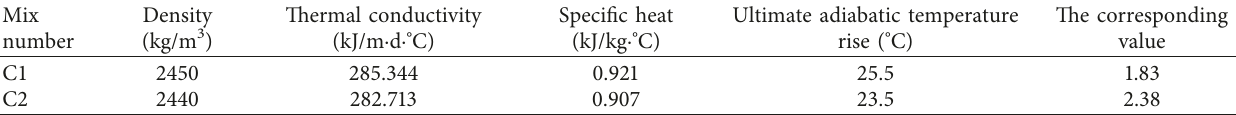
Table 4: The thermal parameters involved in Method